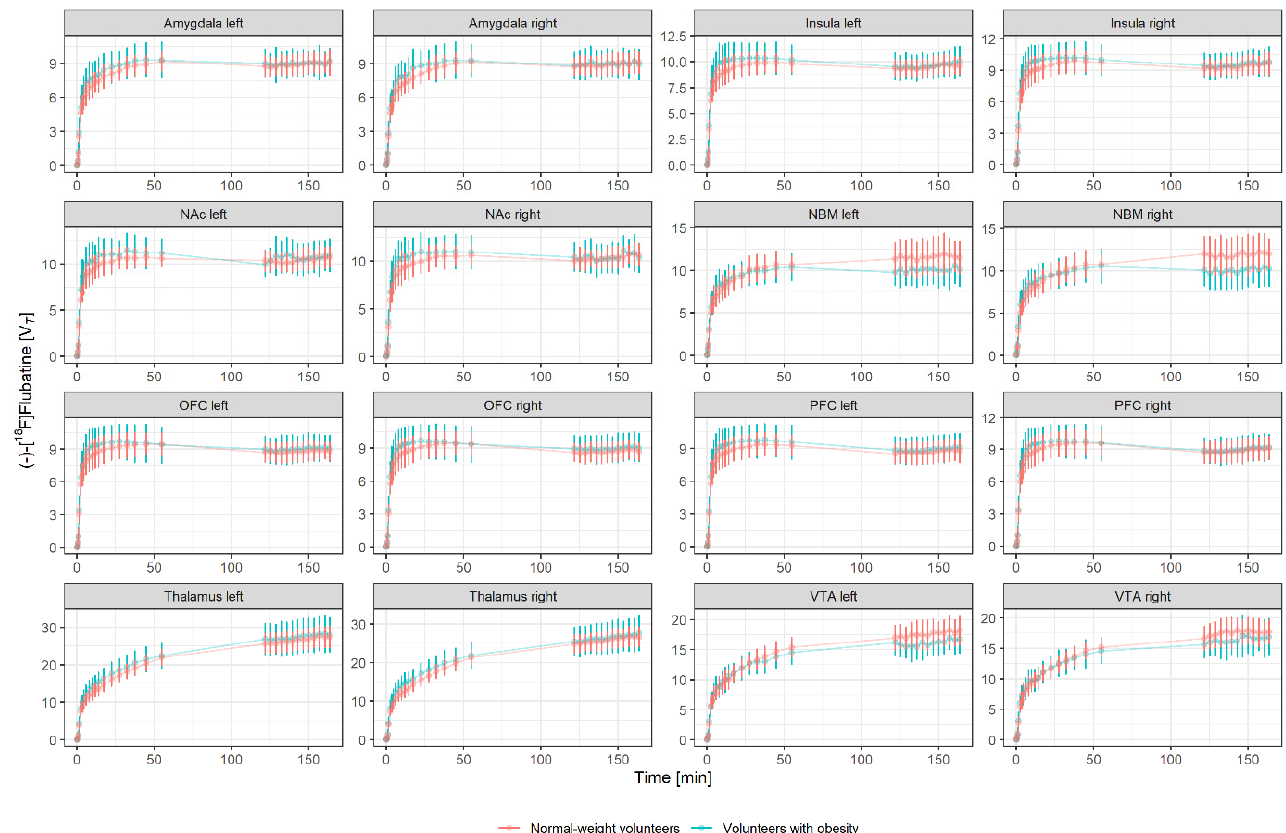
Figure 2. Generated average time activity curves after applying ( − )-[ 18 F]flubatine in a bolus plus constant infusion protocol of both study cohorts for each volume of interest; first phase from 0 to 60 min p.i. consisting of 20 frames and second phase from 120 to 165 min p.i. consisting of 13 frames.